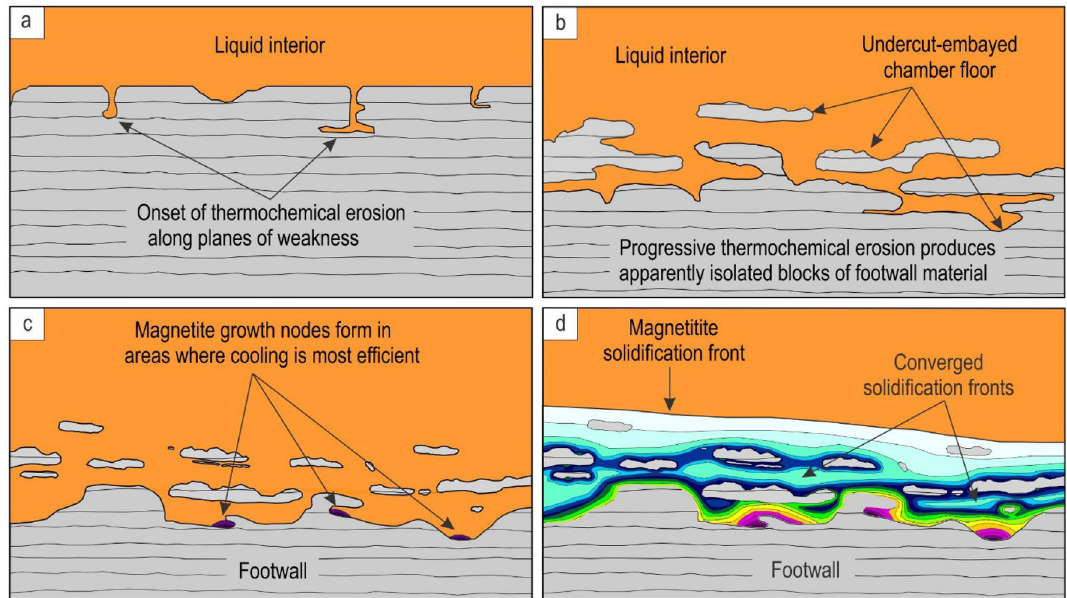
Figure 4. Physical model for the origin of the undercut-embayed chamber floor and propagation of a solidification front therein. (a) Floor cumulates with an initial planar surface undergo thermochemical erosion along points/planes of weakness by a newly-emplaced reactive melt; (b) As erosion progresses, blocks that appear isolated in two dimensions but still connected with the floor in three dimensions may form, eventually resulting in the undercut-embayed chamber floor. (c) With time, thermochemical erosion comes to a halt and, after some degree of cooling, magnetite starts to nucleate and grow in areas where heat loss is most rapid, such as in depressions or underneath fragments partly attached to the floor. (d) Crystal nucleation and growth from the floor and fragments results in omnidirectional propagation patterns of the solidification front, with some converging solidification patterns in the vicinity of the chamber floor. The figure is prepared using CorelDRAW (version